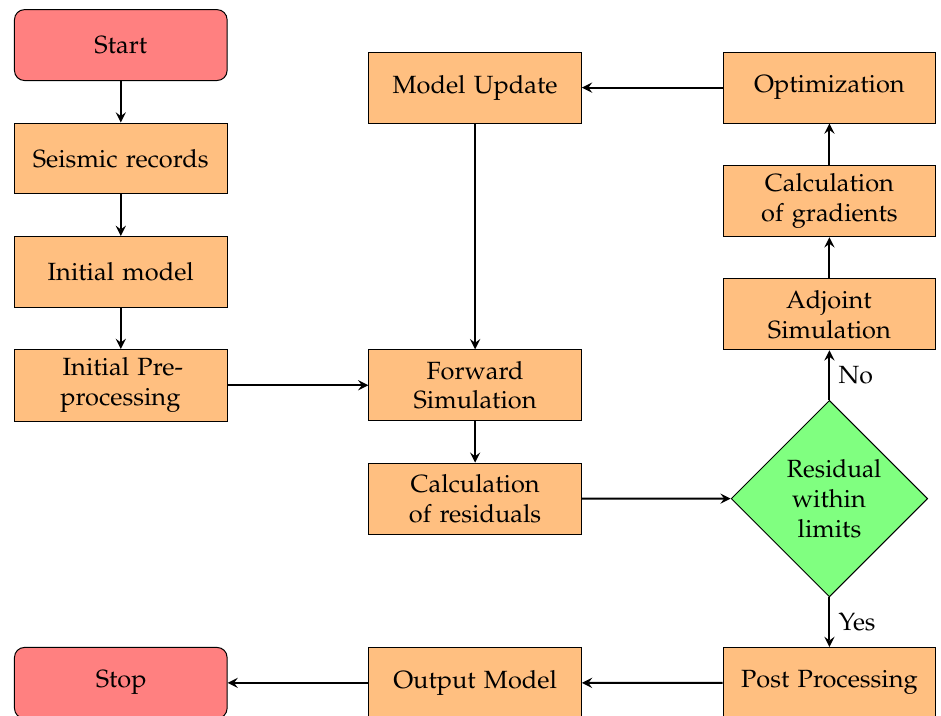
Figure 2. A flowchart of Seismic Full Waveform